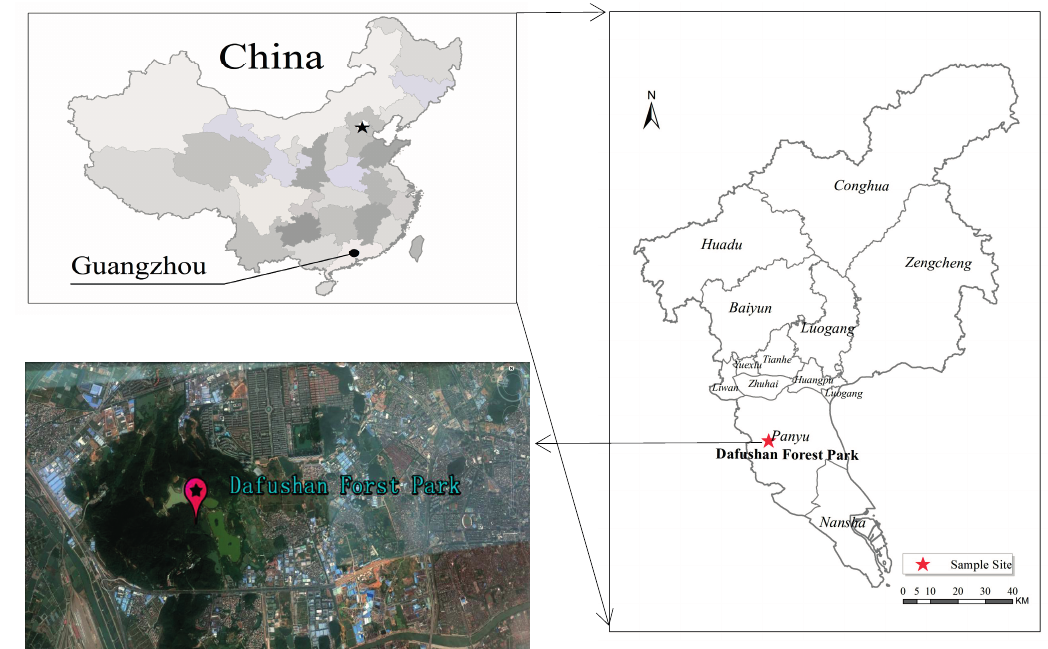
Figure 2. Locations of Dafushan forest park in